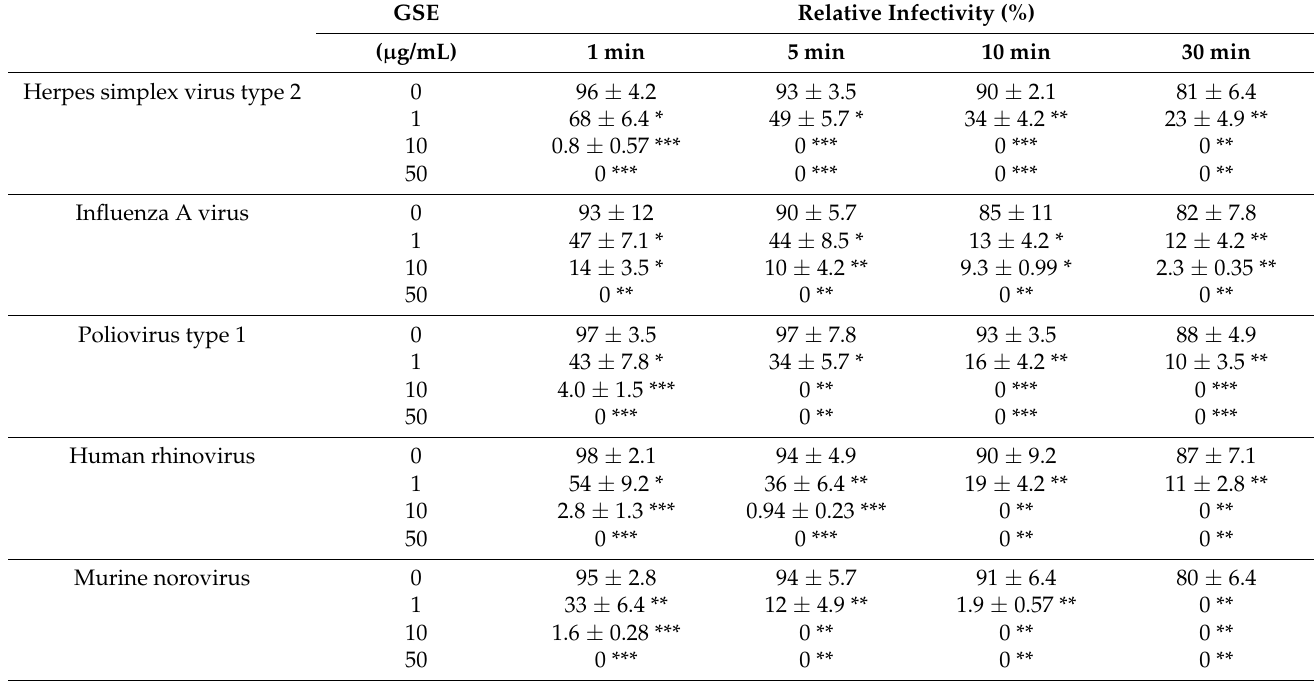
Table 2. Virucidal activity of GSE against enveloped and non-enveloped viruses.